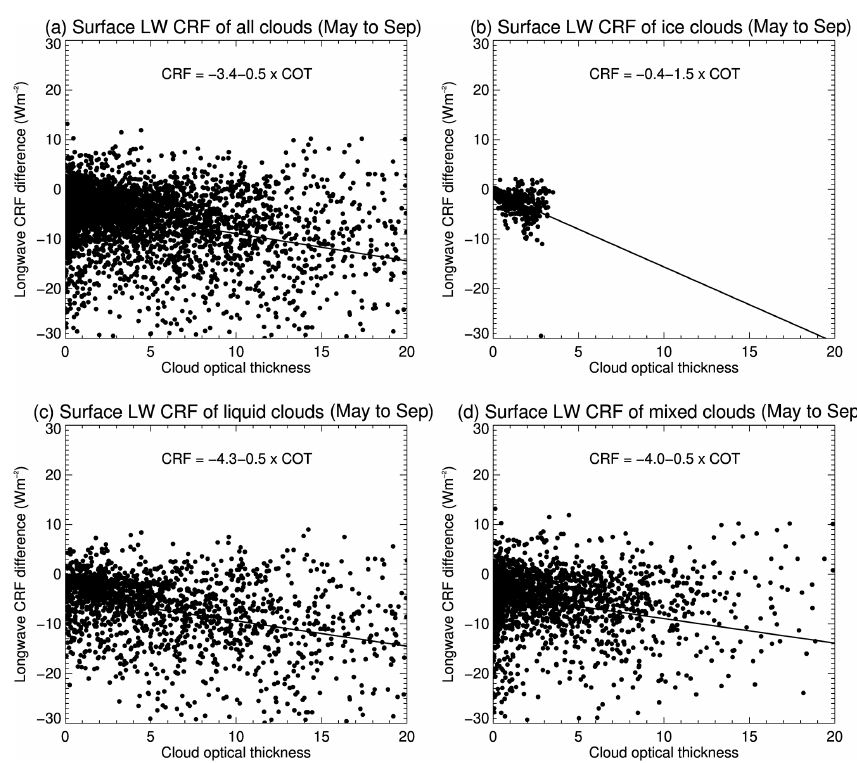
Figure 12. Scatterplots of longwave cloud radiative forcing at the surface using clouds identified by combined CloudSat and CALIPSO and clouds from surface observations and cloud optical thickness for (a) all clouds, (b) ice clouds, (c) liquid clouds, and (d) mixed-phase clouds below 1km from May to September during the SHEBA experiment.